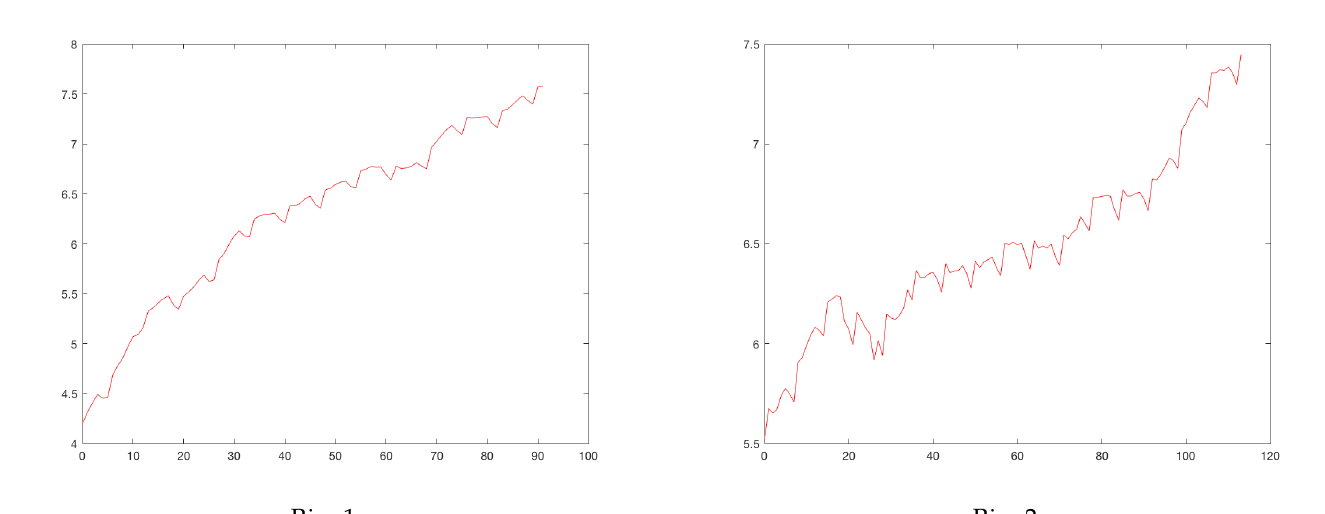
Figure A24. Paris’s rises. Horizontal axis, days; vertical axis: logarithm of daily cases.